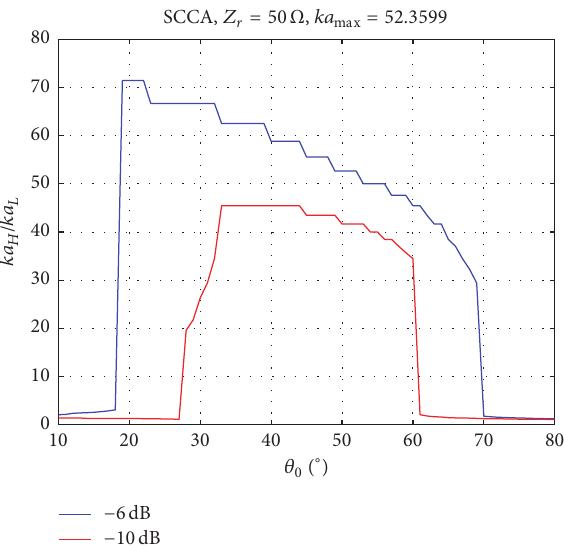
Figure 7: 𝑘𝑎 𝐻 /𝑘𝑎 𝐿 × 𝜃 0 for the theoretical SCCA